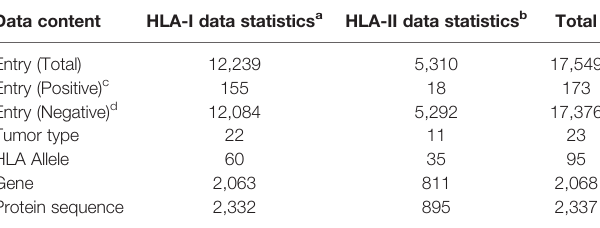
TABLE 1 | Data statistics in